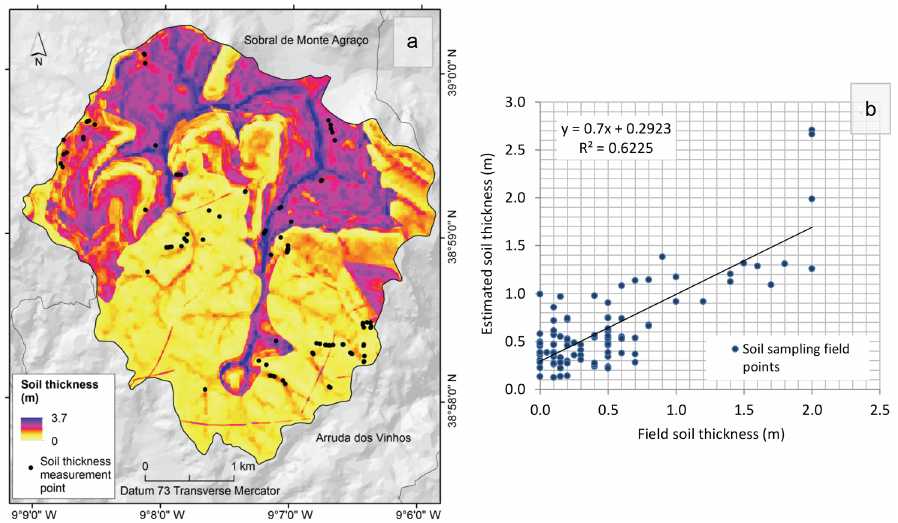
Figure 4. (a) Soil thickness map; (B) correlation between the field-measured soil thickness at sampling points and the estimated soil thickness. The eight sampling field points with more than 1m error are not plotted.